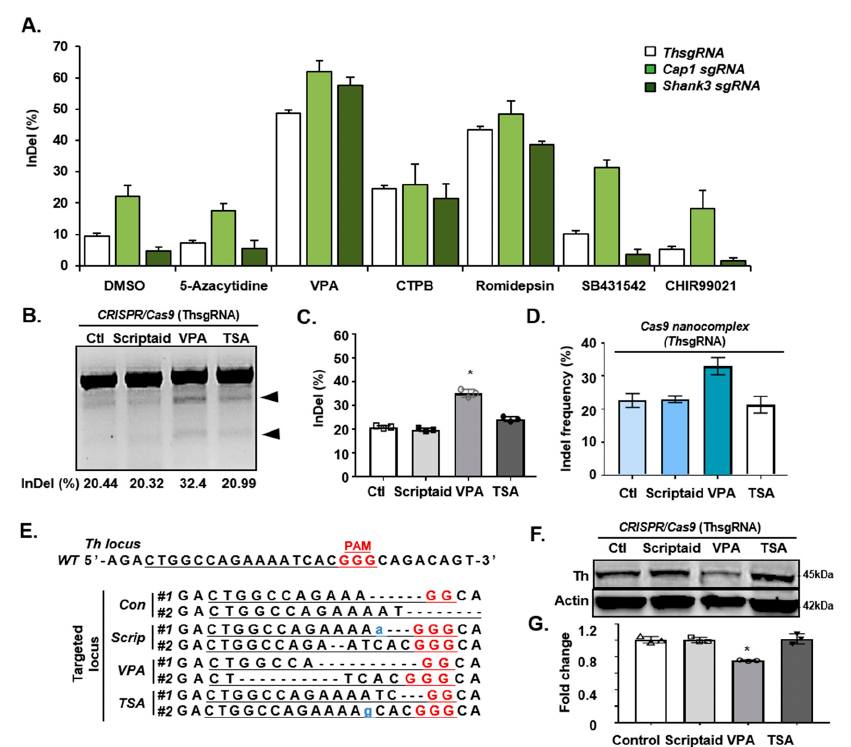
Figure 1. Valproic acid (VPA) enhances clustered regularly interspaced short palindromic repeats (CRISPR)/Cas9 ‐ mediated in vitro targeting efficiency. ( A ) Percentage of InDel frequencies, according to the Surveyor assay results. The assay was performed with various sgRNAs targeting Th, Cap1, and Shank3 genes in mESCs in the presence of various small molecules (DMSO, 5 ‐ azacytidine, VPA, CTPB, Romidepsin, SB431542, or CHIR99021), by transfection with dual Cas9 and sgRNA vector. ( B ) The Surveyor assay in mESCs co ‐ treated with Scriptaid, VPA, or Trichostatin A (TSA) and targeted for Th. Ctl, control. ( C ) Percentage of the InDel frequencies according to the Surveyor assay results. Data are expressed as mean ± SD, n = 3. * p < 0.05, one ‐ way analysis of variance (ANOVA) with Tukey’s post ‐ hoc test. ( D ) The InDel frequencies on Th gene identified by sequencing of the mESCs co ‐ treated with scriptaid, VPA, or TSA. ( E ) Sanger sequencing analysis of the Th locus in mESCs co-treated with Scriptaid, VPA, or TSA. Red, PAM sequence; Underline, guide sequence. Scrip, Scriptaid. ( F ) Western blot showing the e ff ect of scriptaid, VPA, or TSA co-treatment in Th protein levels in mESC-derived dopaminergic neurons. ( G ) Quantification of the western blot analysis in Figure 1F. Data are expressed as mean ± SD, n = 3. * p < 0.05, one-way ANOVA with Tukey’s post-hoc test. The images in B and F are each representatives of ≥ 3 similar